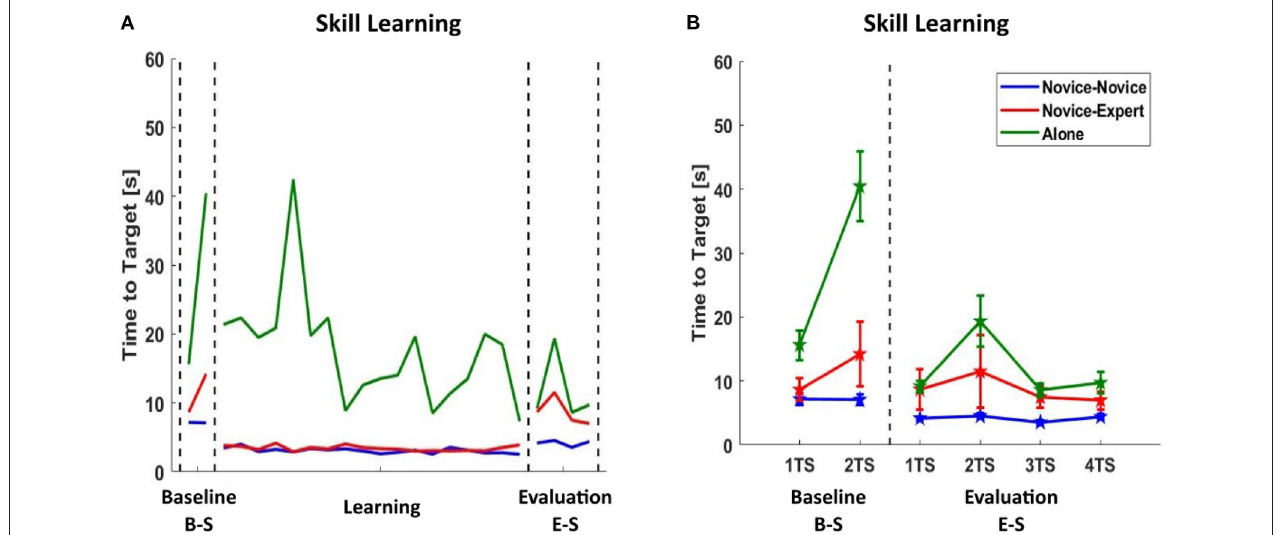
FIGURE 4 | Comparison of an average of Time to Target in terms of skill learning in second (the duration to bring the virtual mass to the target position). N-N (blue), N-E (red), or Alone (green) - (A) Average variation of Time to Target between the first and the last target set in the three phases of the experimental protocol; baseline (B-S), learning and evaluation (E-S) phase in order. (B) Average of Time to Target in each target set (TS) of baseline (B-S) and evaluation (E-S) phase. The Baseline phase includes two TS, and the evaluation phase includes four TS. The dispersion bars represent the SE and are not shown on (A) to highlight the